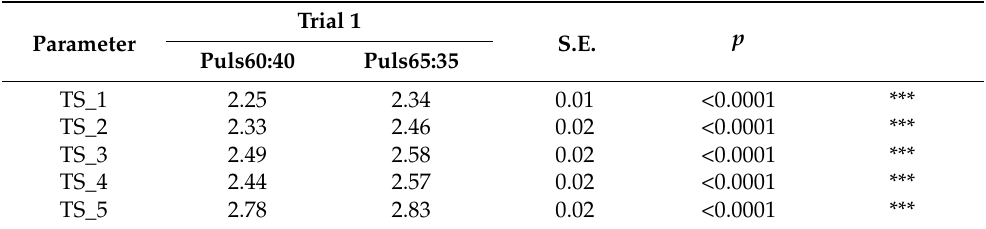
Table 6. Least-square means (LSMs), standard error (S.E.), and statistical difference ( p -value) of the teat-end scores (TS-1 to TS-5) in chronological order for Trial 1. Parameter